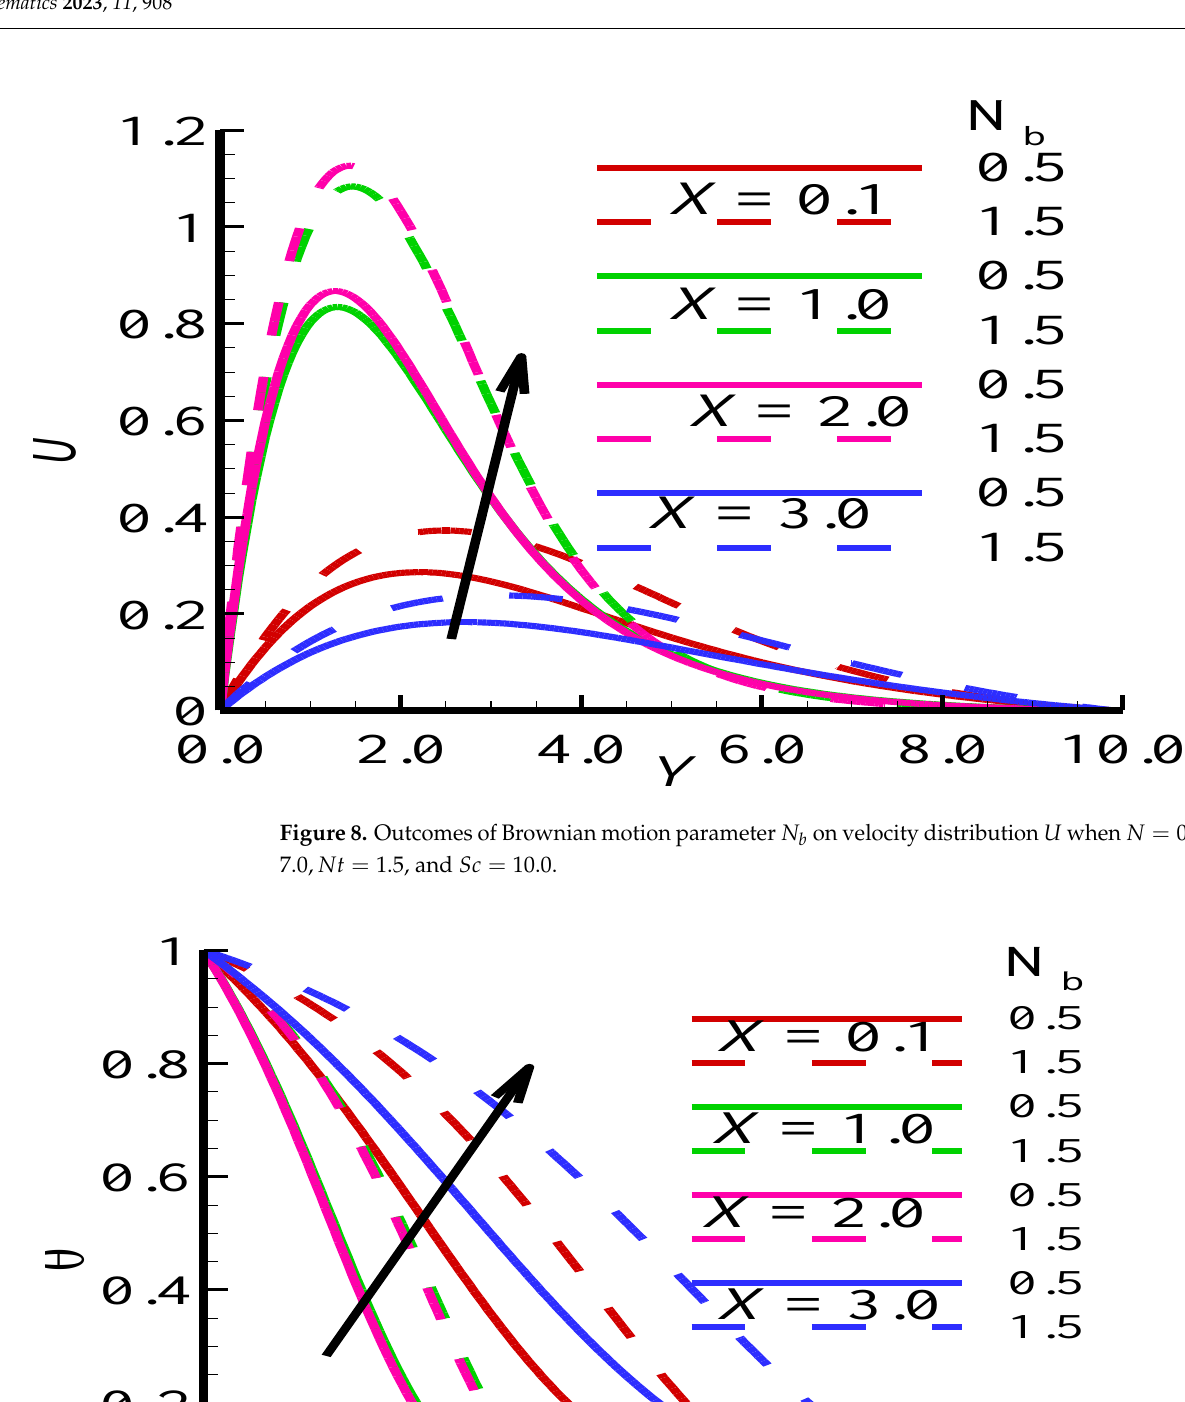
Figure 7. Outcomes of thermophoresis parameter 𝑁 𝑡 on mass concentration 𝜙 when N = 0.5, Nb = 1.5, Pr = 7.0, and Sc = 10.0.